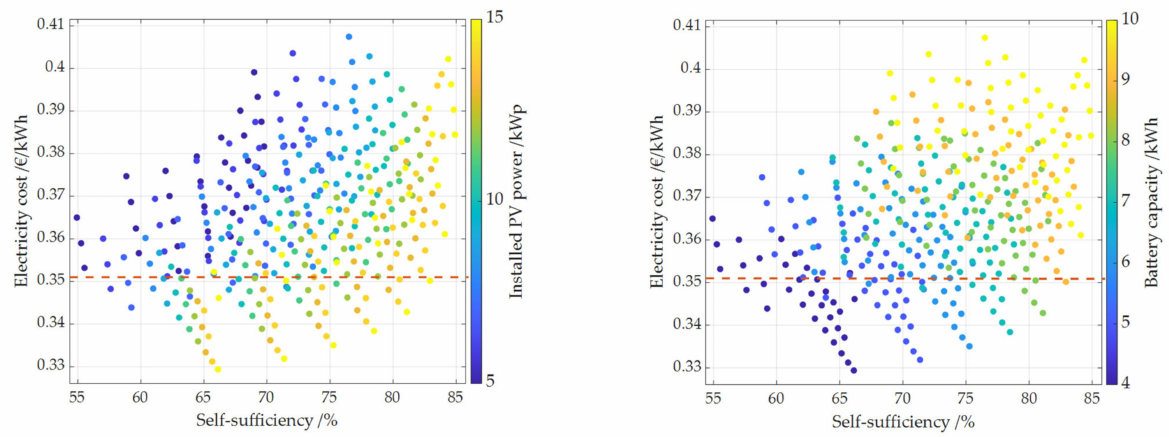
Figure 13. Electricity costs as a function of self-sufficiency. The size of the PV system is shown in color left panel and the capacity of the battery is shown in color in the right panel. The simulation is based on an annual electricity price increase of 1% and the expected feed-in tariff in June 2021 (7.47 cent/kWh for PV systems up to 10 kWp and 7.25 cent/kWh for PV systems up to 40